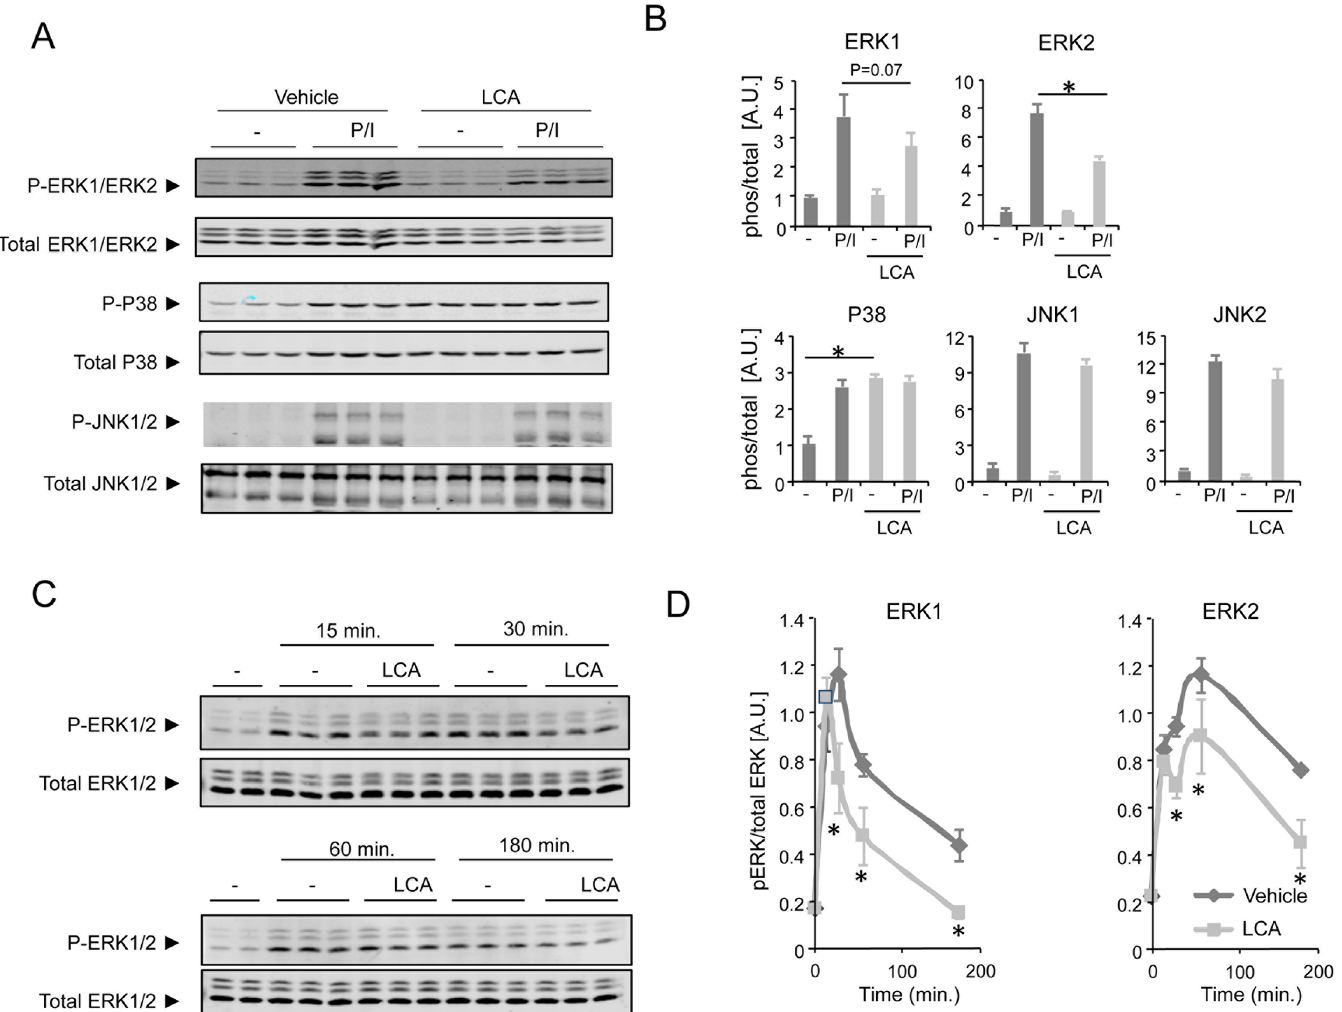
Fig 3. LCA inhibits ERK phosphorylation in Jurkat T cells. (A) Western blot images and (B) Quantificationresults of total and phosphorylated levels of ERK1/2, P38 and JNK1/2 in responseto 10 μ M LCA (light grey bars) or vehicletreatment (dark grey bars) in P/I-activated or resting Jurkat T cells. (C) Western blot images and (D) Quantificationresults of ERK1/2 phosphorylation in response to 10 μ M LCA (light grey lines) or vehicle (dark grey lines) treatment in P/I-activated Jurkat T cells. LCA, lithocholicacid; P/I, PMA/ionomycin; AU, Arbitrary units. Results represent the mean ± SEM. * Statistically significant, P < 0.05. Experimentswere performed in triplicates and repeated at least